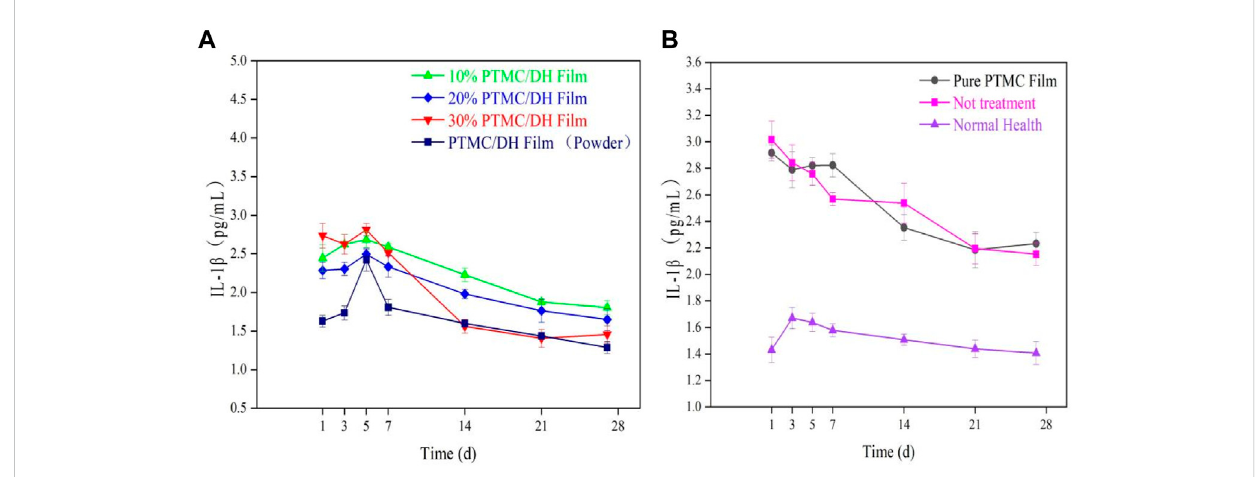
FIGURE 13 (A) IL-1 β trend in the experimental group over 28 days; (B) IL-1 β trend in the control group, blank group and normal healthy